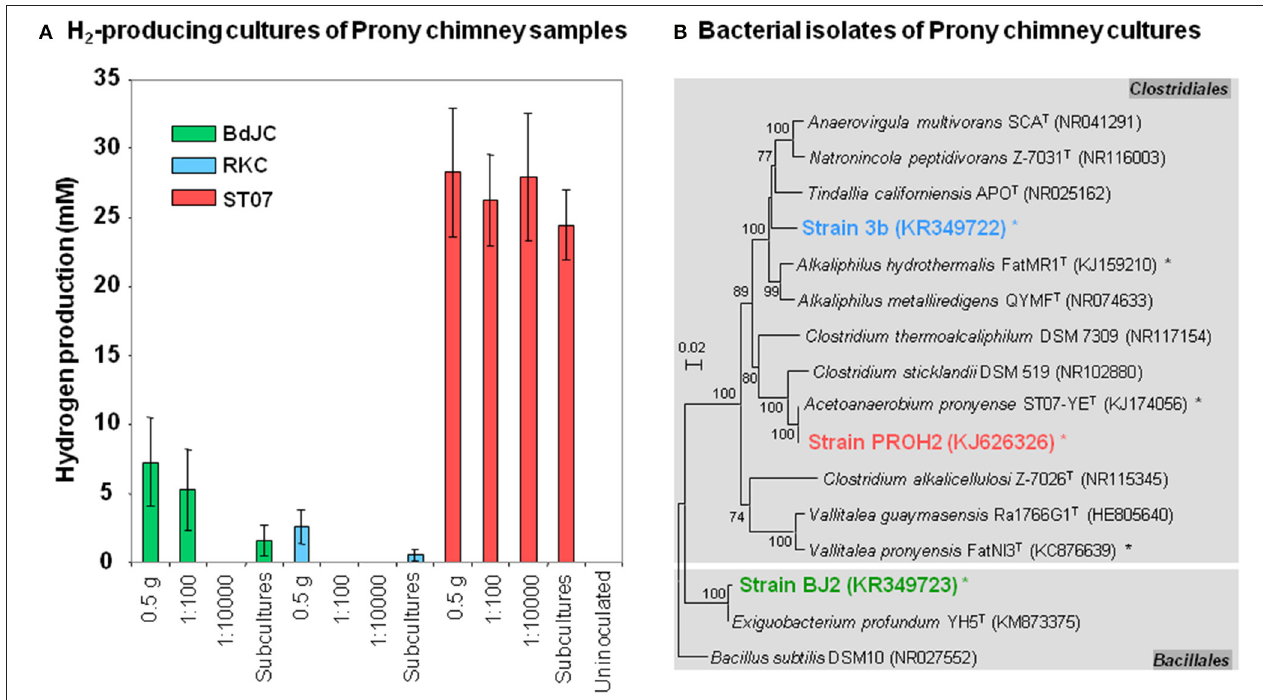
FIGURE 6 | Hydrogen-producing cultures obtained from hydrothermal chimneys of the Prony bay: performances and identification of bacterial isolates. (A) Hydrogen-producing cultures were attempted using several dilutions of chimney subsamples from three Prony sites: “Bain des Japonais” (BdJ), “Rivière des Kaoris” (RK), and the “Aiguille de Prony” (ST07). The suffix “C” in sample names stands for “chimney.” Subcultures were also performed from the first round of positive enrichment cultures. Values are mean of biological replicates ± standard deviation (errors bars). (B) Maximum-likelihood tree based on 16S rRNA gene sequences showing the phylogenetic position of Firmicutes strains 3b, PROH2, and BJ2, isolated from hydrogen-producing cultures of Prony hydrothermal Field (PHF). Representative sequences in the tree were obtained from GenBank (accession number in the brackets). Other bacterial species isolated from PHF are indicated by asterisks. Bootstrap values > 70% are indicated at